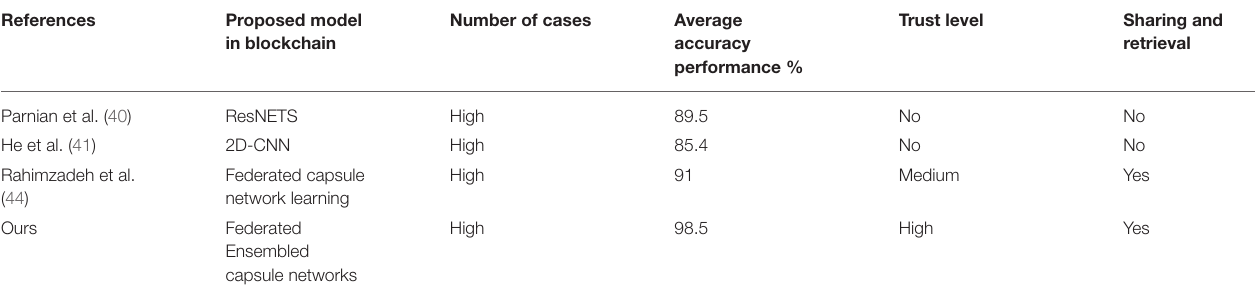
TABLE 7 | Comparative analysis between the blockchain-based learning models for COVID-19 detection of diseases using dataset